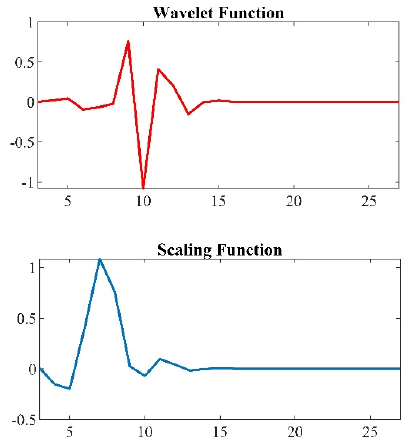
Figure 4. DWT decomposition.